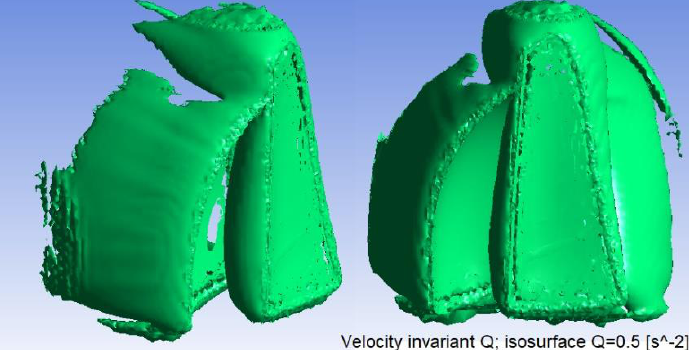
Figure 10. Iso-surfaces of Q-criterion for AWA = 115°.